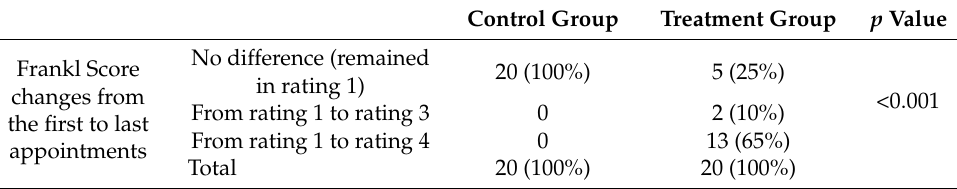
Table 8. Frankl Behavior Rating Scale changes in the treatment and control groups from the first to last